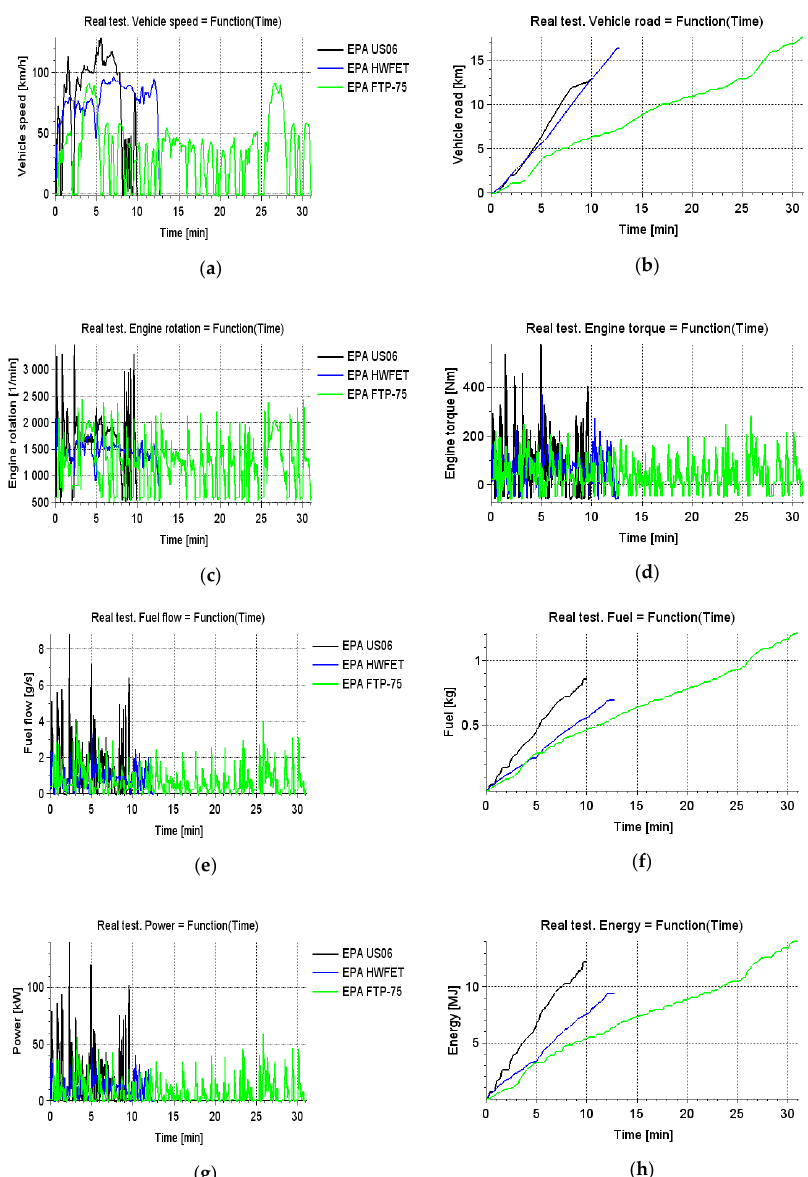
Figure 6. The results of the simulation work for the processed data from EPA tests for the 2013 Mercedes E350 vehicle: ( a ) Waveforms of the instantaneous vehicle speed values; ( b ) Waveforms of the instantaneous values of the distance travelled by the vehicle; ( c ) Waveforms of the instantaneous vehicle engine speed values; ( d ) Waveforms of the instantaneous values of torque generated by the vehicle engine; ( e ) Waveforms of the instantaneous values of the fuel stream powering the vehicle engine; ( f ) Waveforms of the instantaneous fuel consumption values for the vehicle; ( g ) Waveforms of the instan- taneous values of power generated by the vehicle’s engine; ( h ) Waveforms of the instantaneous values of mechanical energy generated by the vehicle engine.